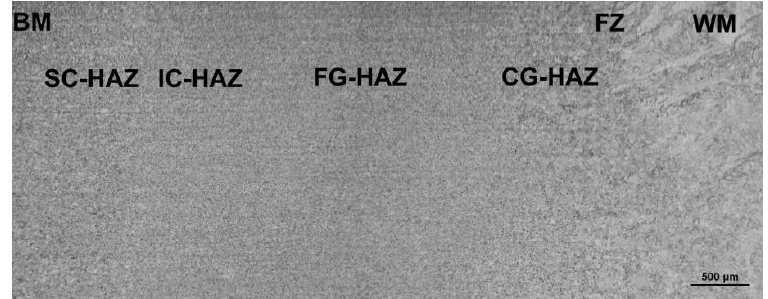
Figure 4. Light-optical micrograph of T92 / T92 weldment after the tempering PWHT-1.